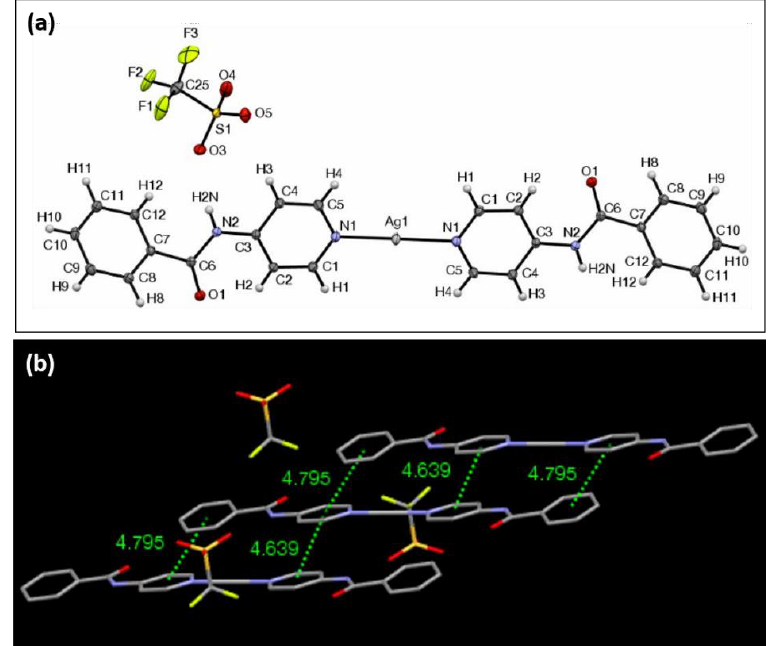
Figure 4. ( a ) ORTEP view of complex 3 with ellipsoids drawn at 30% probability. ( b ) The view of π– π interactions of three adjacent molecules of complex 3 , showing centroid-to-centroid distances of less than 4.80 Å .